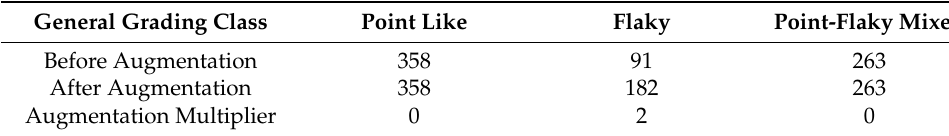
Table 2. Augmentation Process for General Grading Dataset.